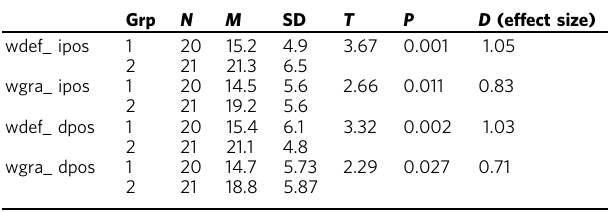
Table 1 t -Test, immediate post-test, and delayed post-test scores of experimental and control groups in the two-word recognition